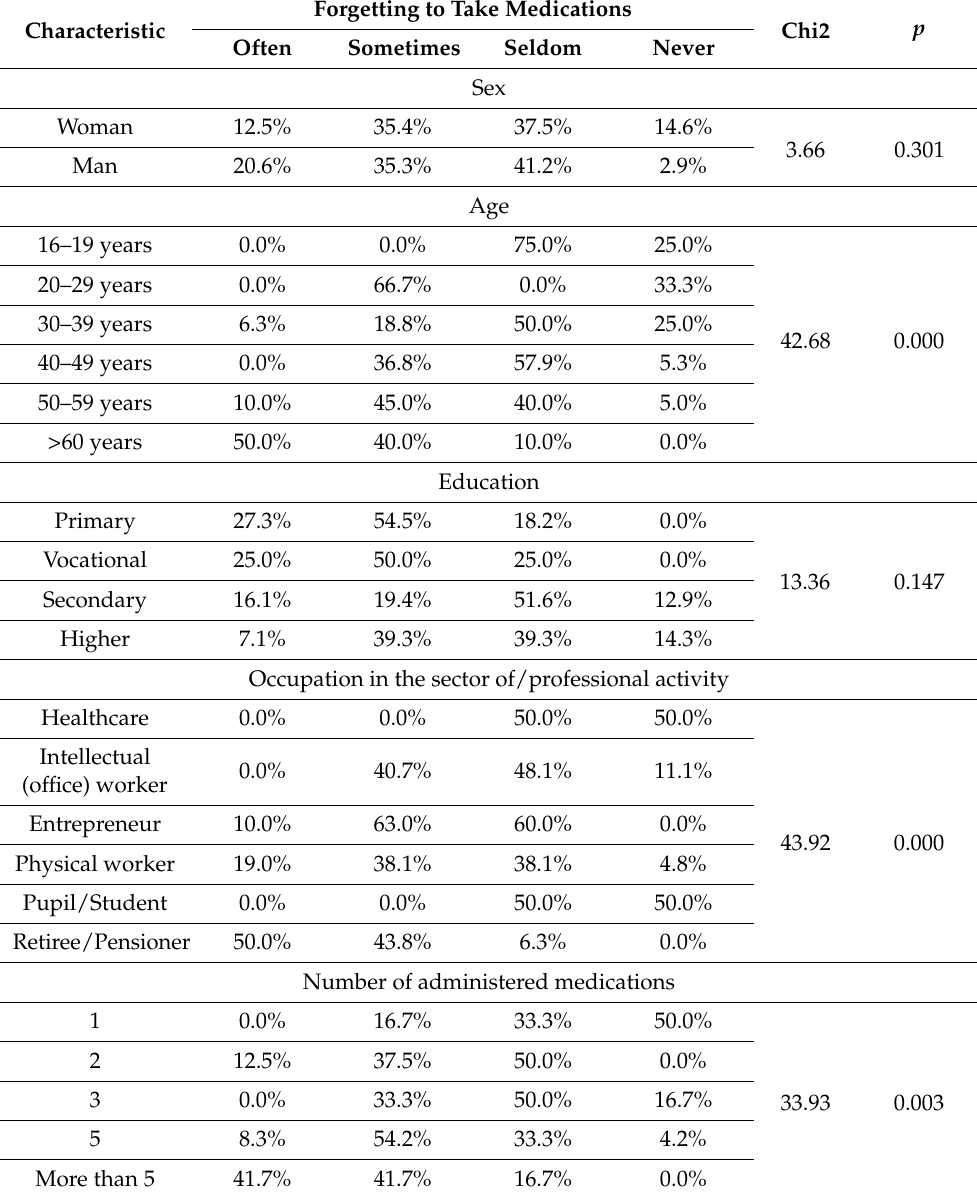
Table 1. The frequency of forgetting to take medications, taking into account the demographic characteristics of the